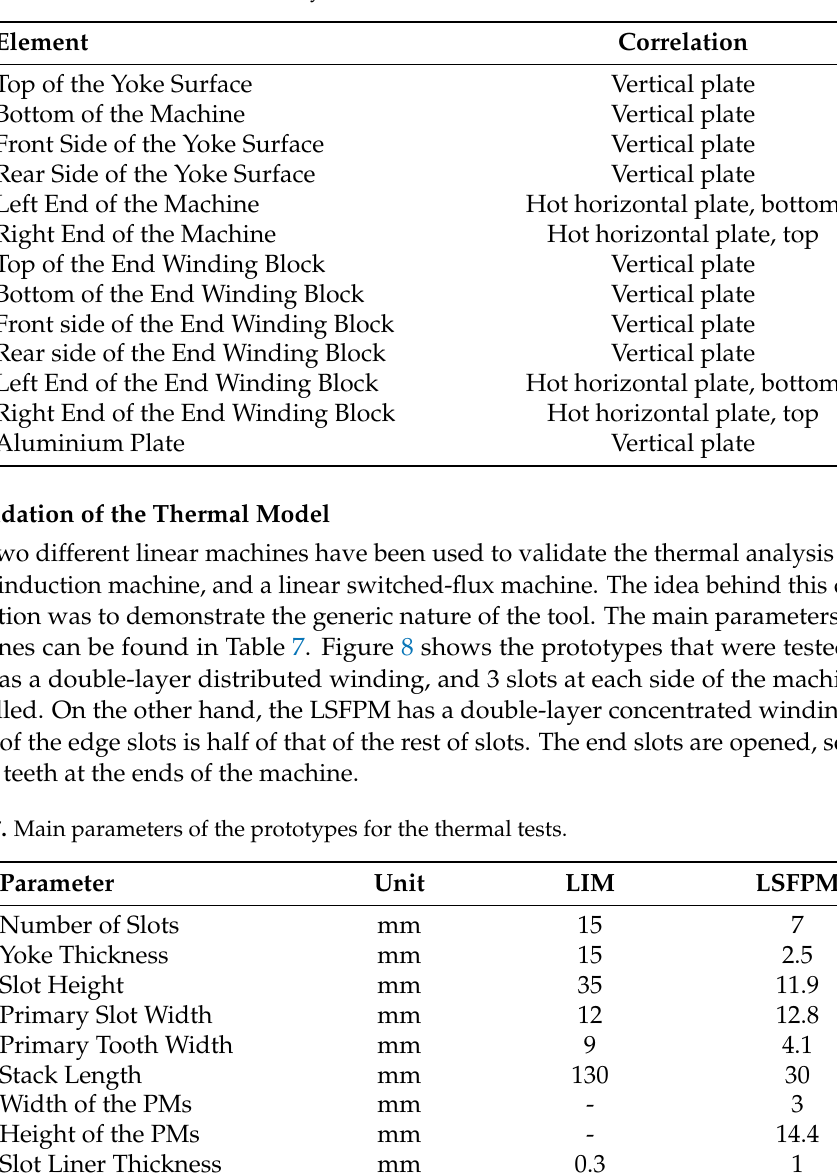
Table 6. Correlations for the vertical layout with the vehicle structure.